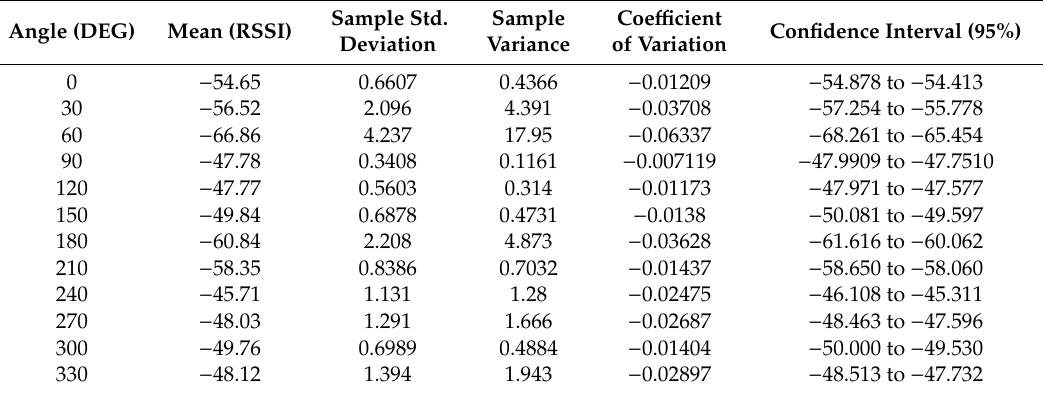
Mean RSSI—Figure 22, Sample Standard Deviation—Figure 23, Coe ffi cient of variation—Figure 24 and Sample Variance—Figure 25. (Statistical processing was performed using the WolframAlpha tools). Table 4. Statistical analysis of RSSI